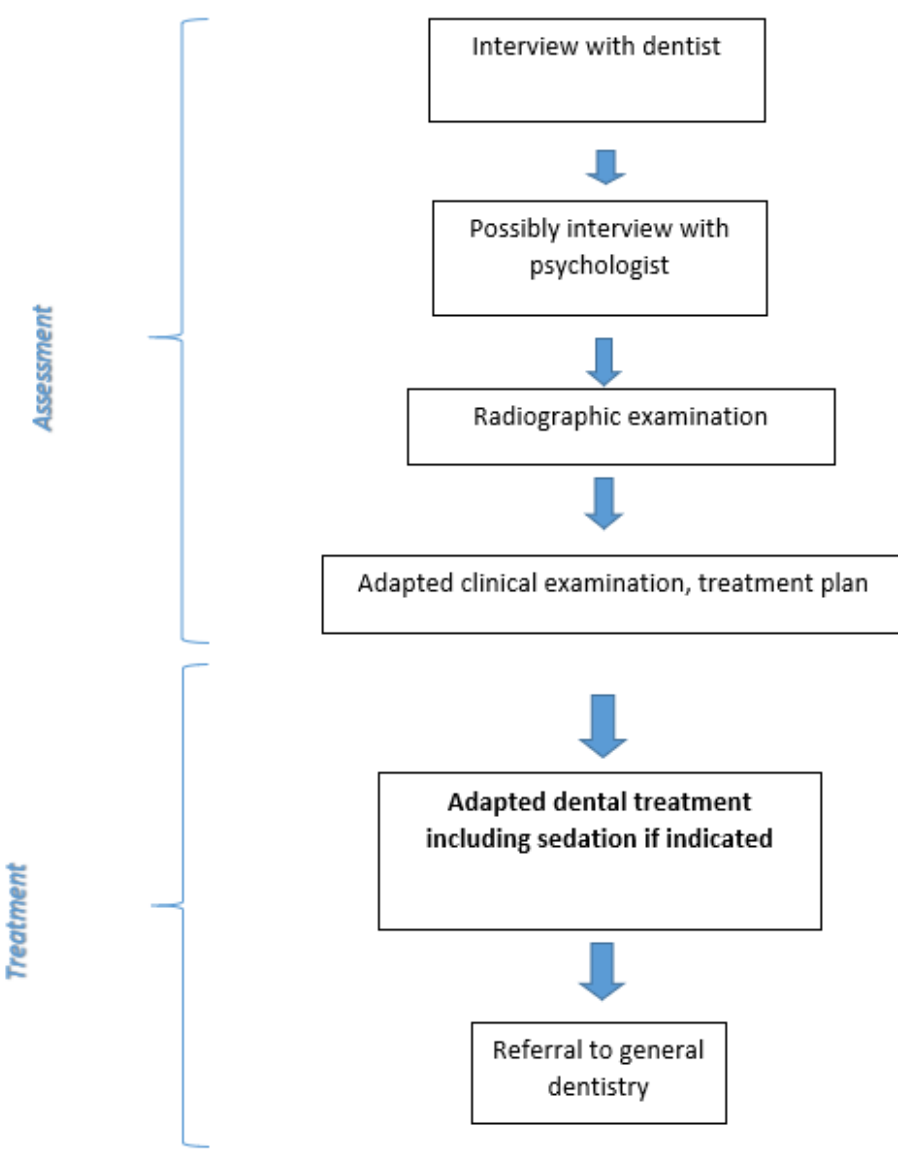
Figure 5. Flowchart for adapted dental treatment of dental anxiety/phobia [27].